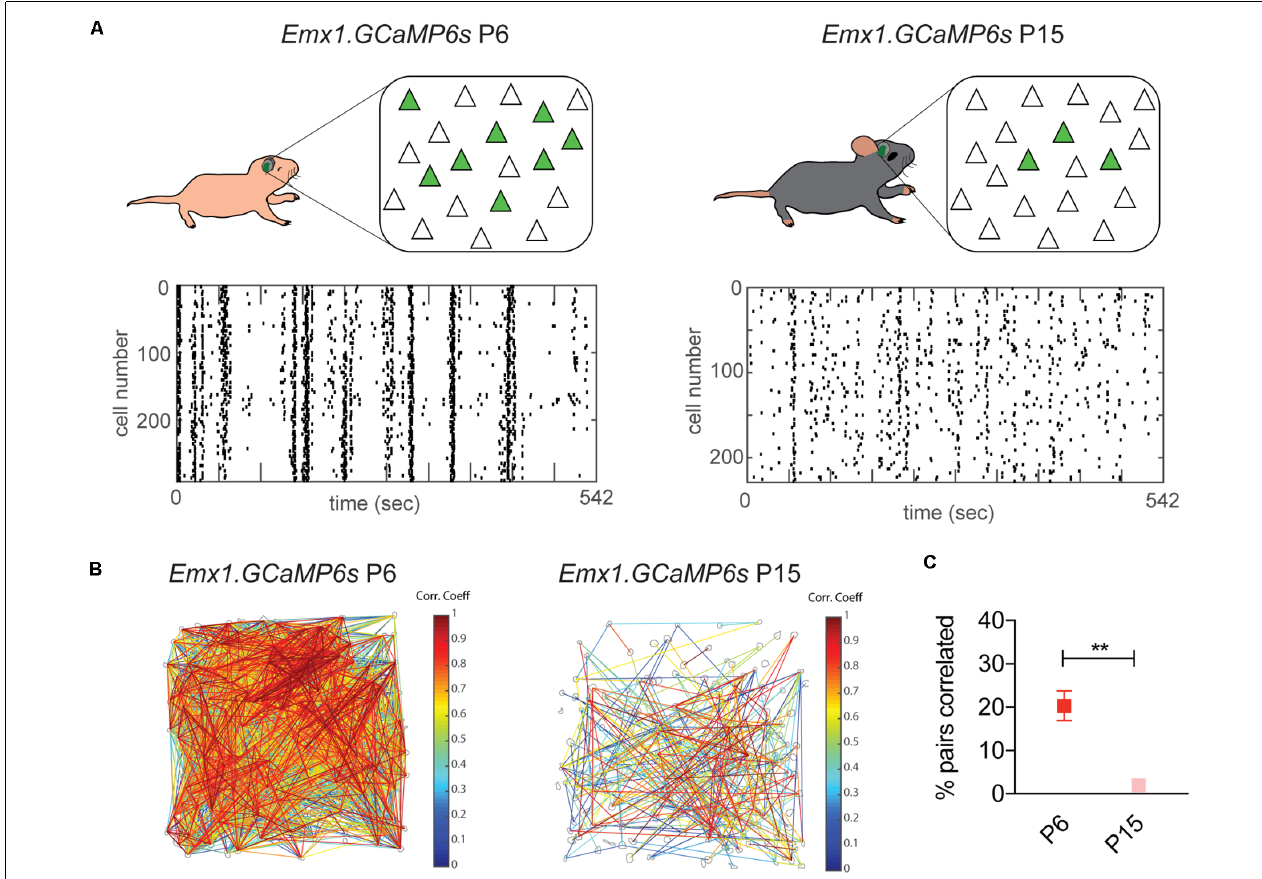
FIGURE 2 | Sparsification of spontaneous cortical activity in S1 by the end of the second postnatal week. Desynchronization of spontaneous cortical activity in S1 measured using in vivo calcium imaging. (A) Top panel: diagrams of in vivo imaging of Emx1.GCaMP6 s mice at P6 and P15, with cranial windows placed over S1. The number of spontaneously co-active Pyr neurons (green) at any given time decreases between P6 and P15. Bottom panel: representative raster plots of neuronal calcium activity at both ages. Each row represents a single neuron imaged during 542 s. Each tick represents the onset of a single calcium event. At P6 neuronal activity is characterized by the co-activation of most neurons imaged in the field of view, visualized in vertical arrangements in the raster plot, while at P15 neuronal activity becomes less synchronized resulting in a “salt and pepper” pattern in the raster plot. (B) Visualization of correlated neuronal activity corresponding to recordings in (A) . Gray contours indicate detected somas in which calcium signals were analyzed. Significantly correlated cell pairs are connected by lines. Line color indicates the magnitude of the correlation coefficient of the connecting pair. (C) Percentage of pairs that are significantly correlated decreases from P6 to P15. Unpaired t-test, ** p = 0.0027. Derived with permission from Che et al.